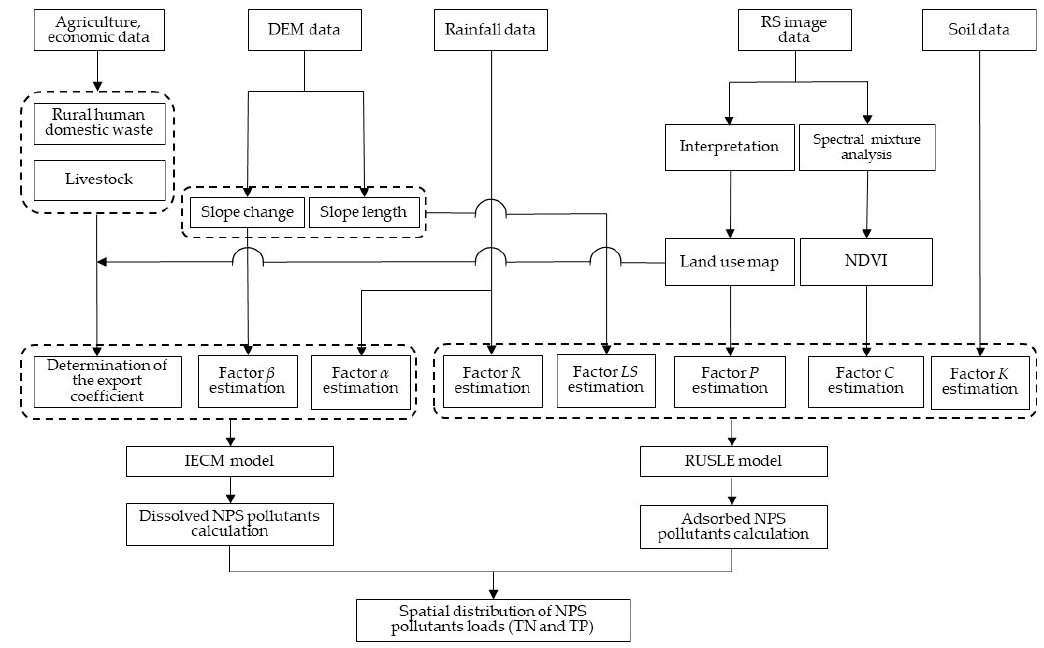
Figure 6. Flowchart showing the process of calculating NPS pollutant loads.